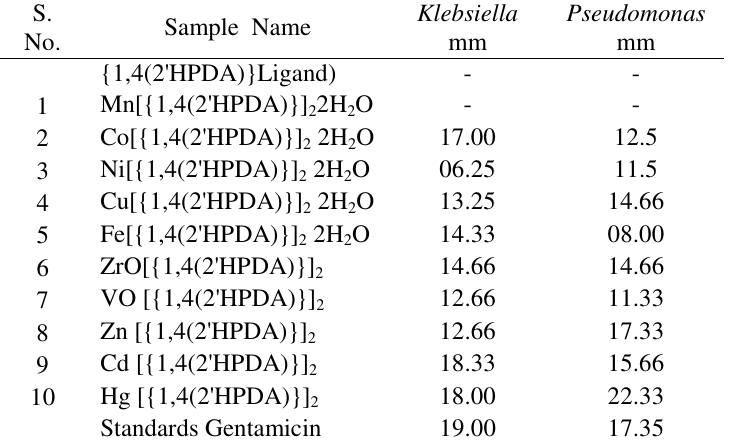
Table 3. Antibacterial activities of {1,4(2'HPDA)} and their metal complexes S.